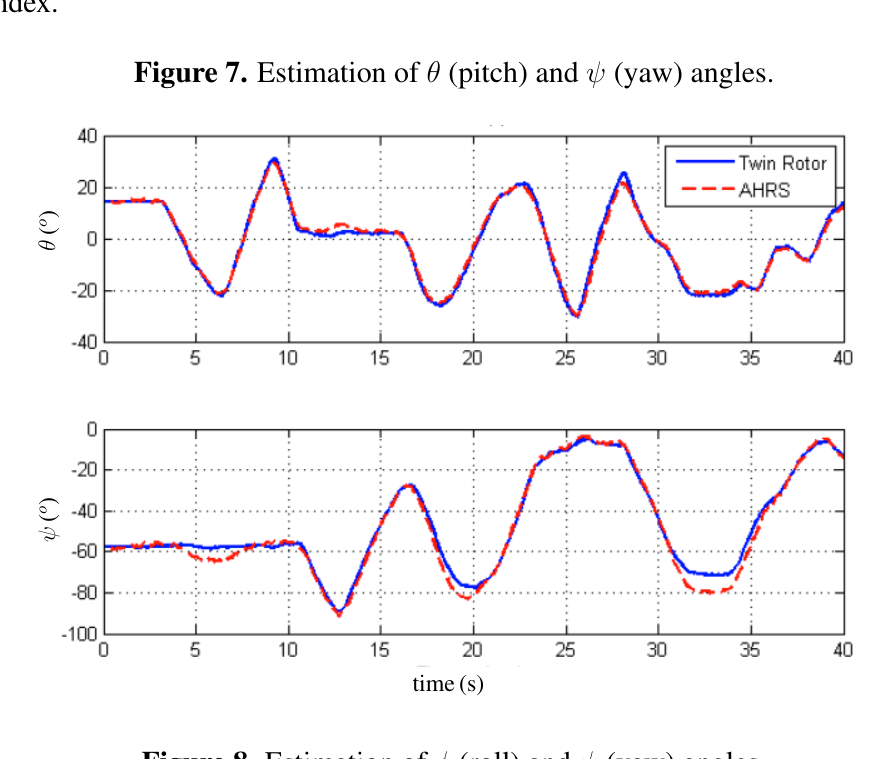
Figure 8. Estimation of φ (roll) and ψ (yaw)